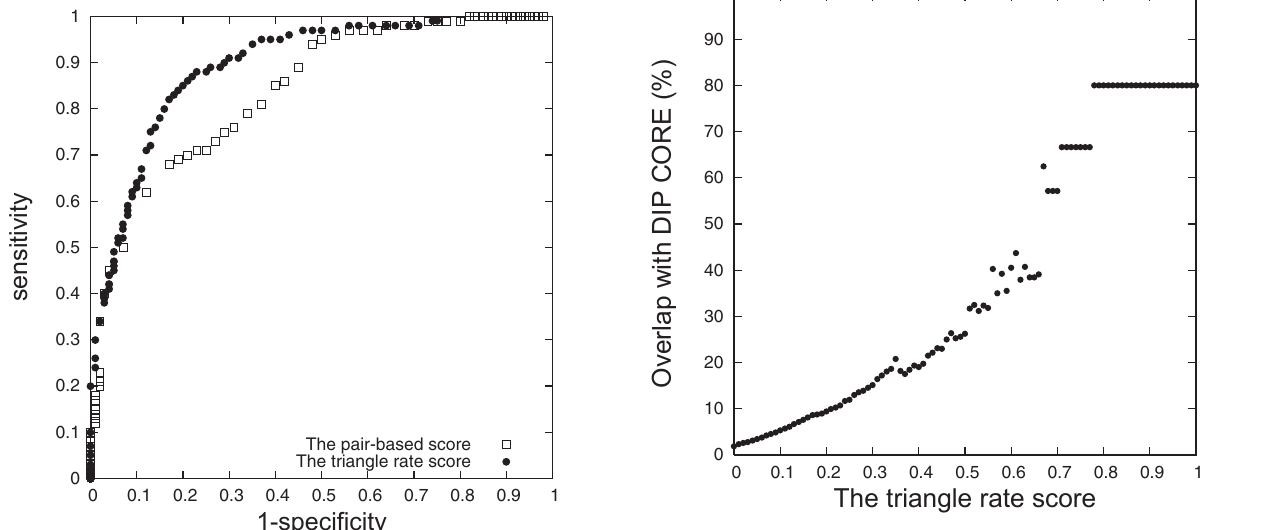
Figure 4. ROC Curves of Pair-Based Score and Triangle Rate Score. The ROC curves for interactions prediction from the triangle rate score and the pair-based score.